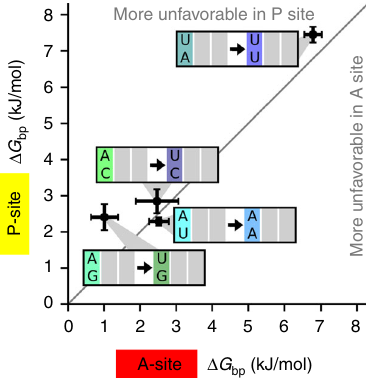
Fig. 5 Comparison of P-site and A-site base pairs. Free-energy differences for the A and the P sites shown as the mean (points) and standard deviations (error bars)